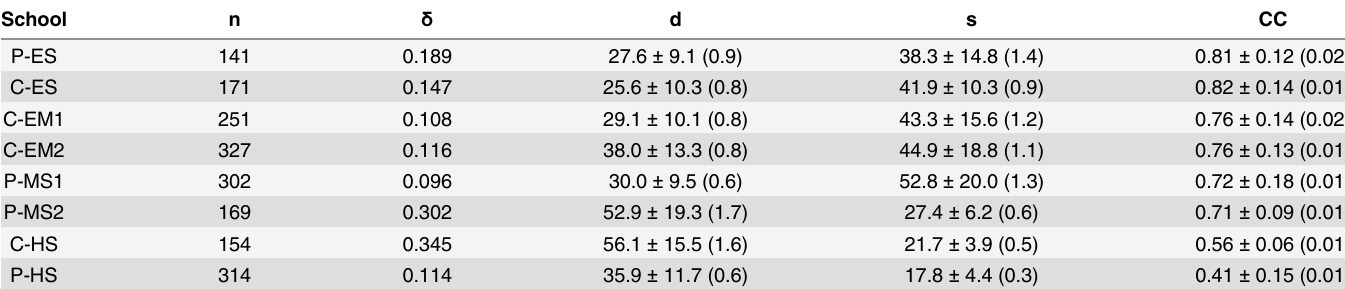
Table 2. Contact network measurements and their standard deviations (and standard errors) for school contact networks *